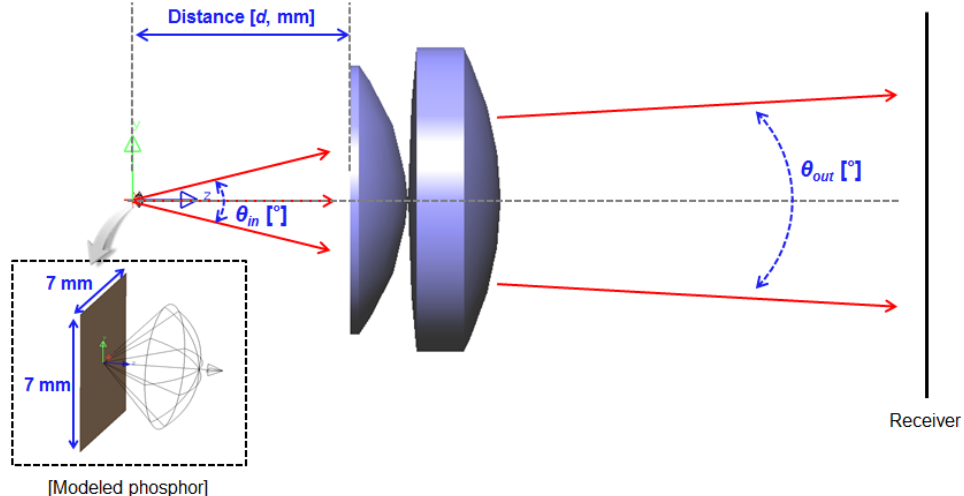
Figure 13. Large-area collimating optical system structure.